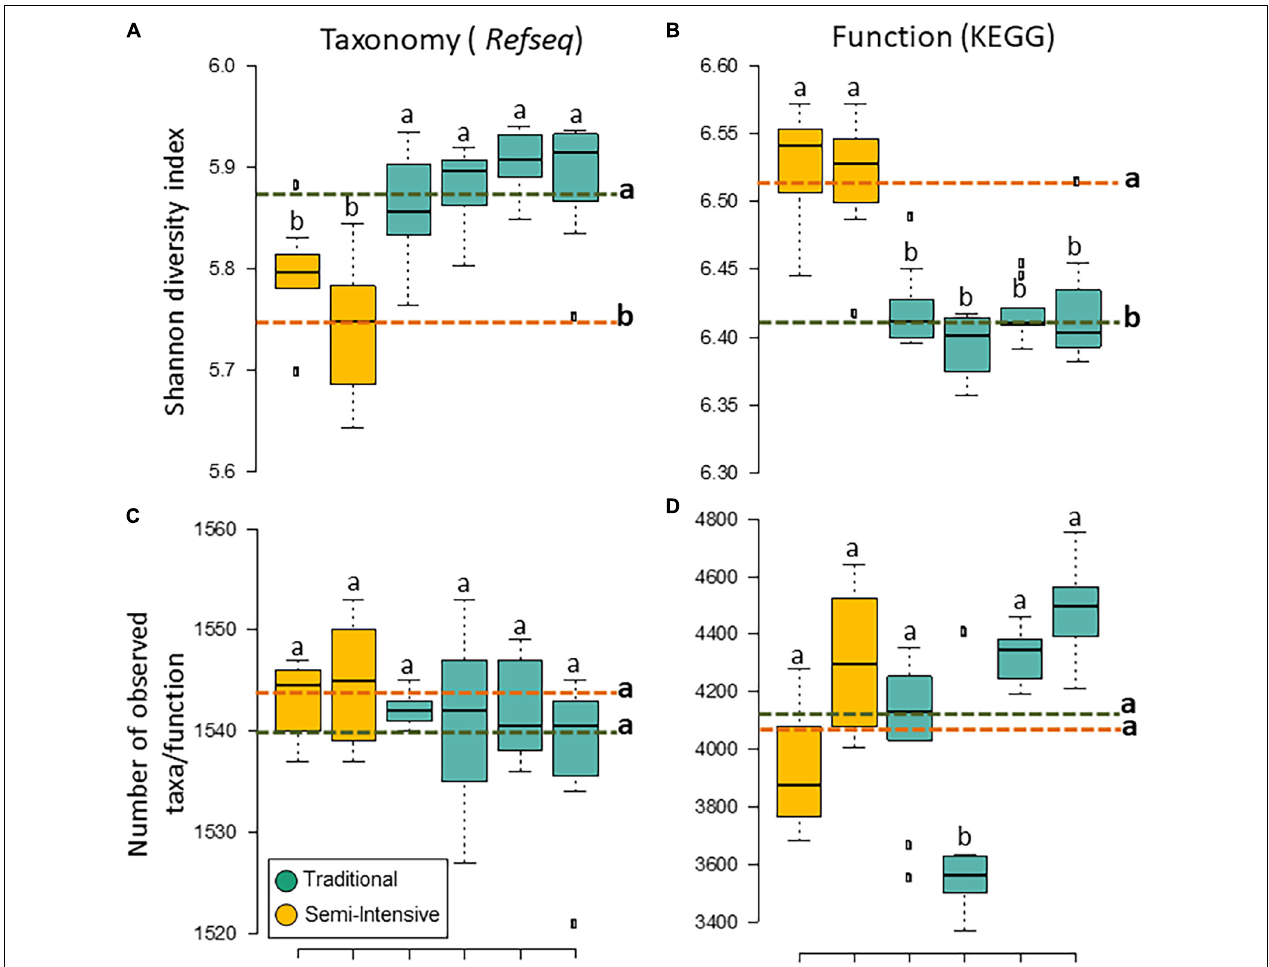
FIGURE 2 | Diversity measurements of microbial communities in the feces of beef cattle reared in semi-intensive (yellow) and traditional (blue) systems. Taxonomic (A) diversity and (C) richness are based on genera level (RefSeq database), and functional (B) diversity and (D) richness are based on subsystem level 3 (SEED database). Error bars represent the standard deviation of four independent replicates. Different lower-case letters refers to significant differences between treatments based on Tukey’s honestly significant difference test ( P < 0.05). The dashed lines represent the average values for each